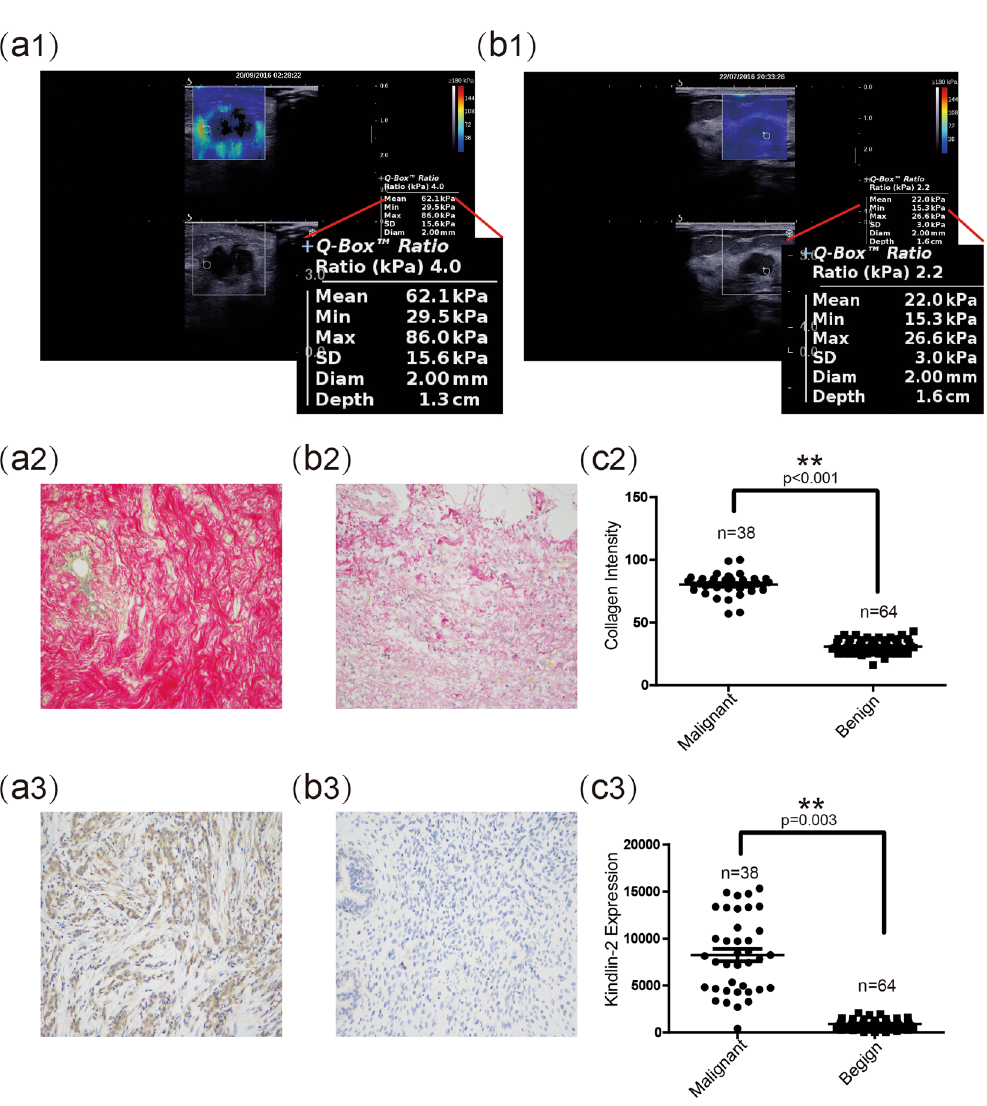
Figure 2. Evaluation of malignant and benign breast nodules by SWE and by histopathological staining for collagen and Kindlin-2 expression. ( a1 ) ( b1 ) Representative SWE images of malignant and benign breast nodules. ( a2 ) ( b2 ) Representative images from Sirius red staining ( × 200) show expression of collagen in malignant and benign breast nodules, respectively. ( c2 ) Quantitative analysis shows that the average intensity of collagen in malignant breast nodules was significantly higher than that in benign breast nodules. ( a3 ) ( b3 ) Representative images of immunohistochemical staining ( × 200) show expression of Kindlin-2 in malignant and benign breast nodules, respectively. ( c3 ) Quantitative analysis shows that the average expression (by integrated optical density of positive reactions) of Kindlin-2 in malignant breast nodules was significantly higher than that in benign breast nodules. Values are means ± SD. Comparisons between two groups were made using Student’s t -test. * p < 0.05, ** p < 0.01. SWE, shear wave elastography; SD, standard